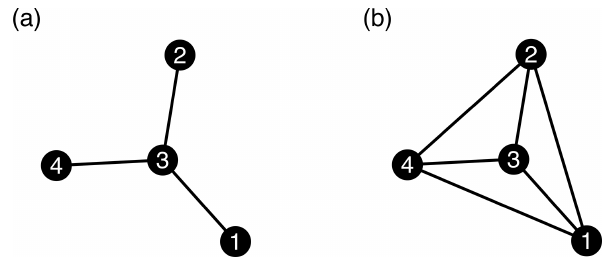
Figure 1. Topology of two sample networks to explain network structures and measures. (a) Network N1 with four nodes and three links; (b) network N2 with four nodes and six